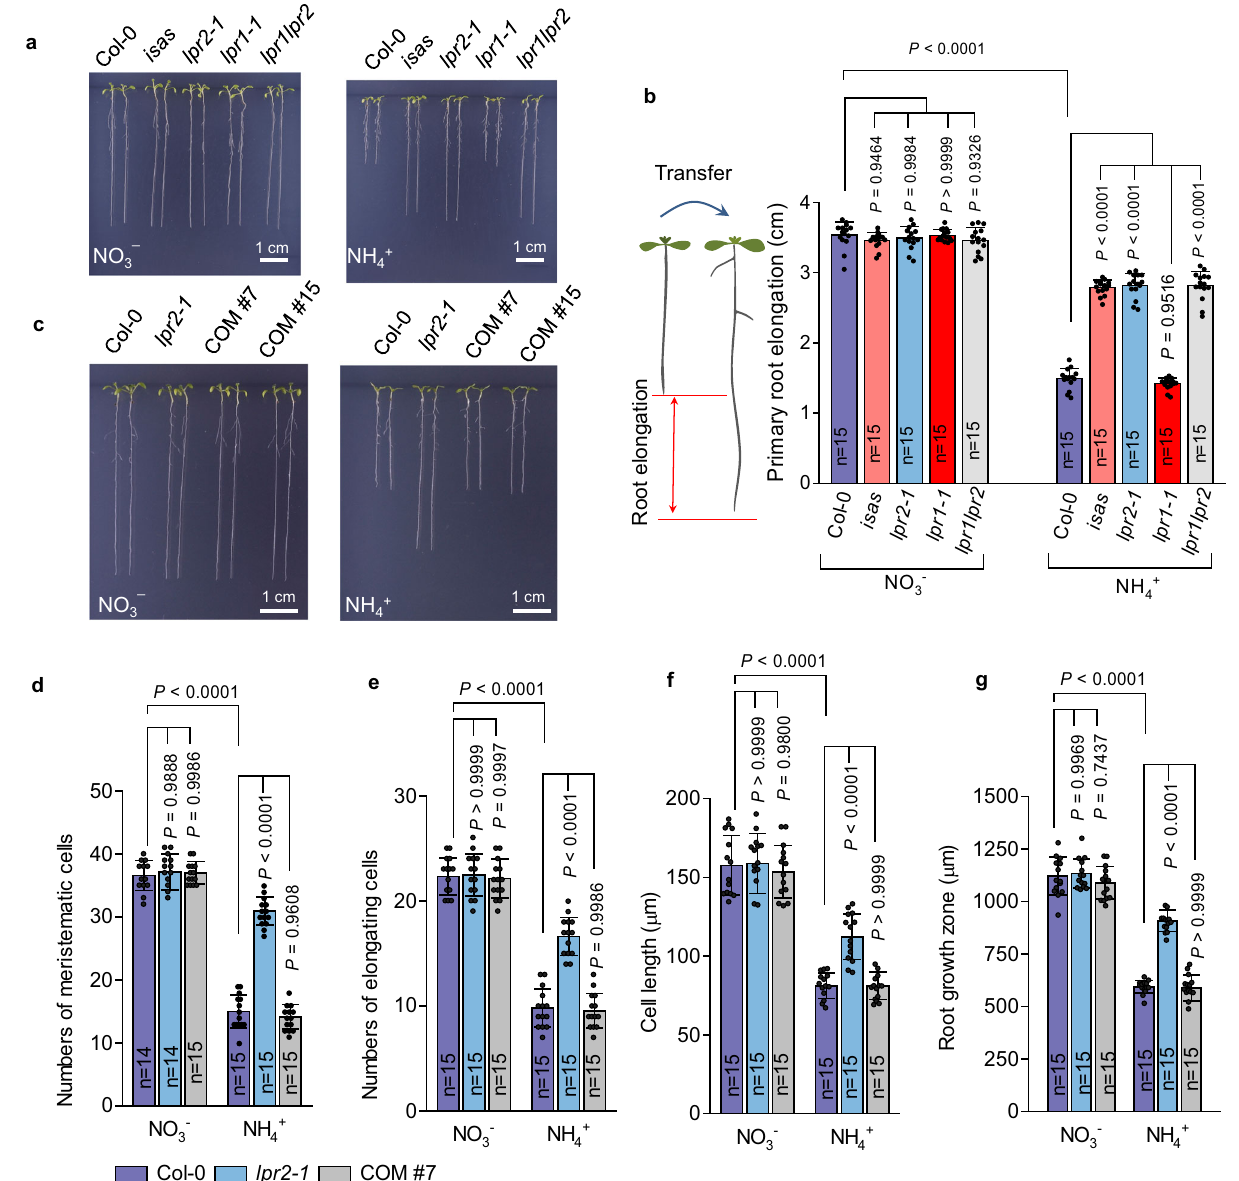
Fig. 1 LPR2-dependent growth inhibition of primary roots in NH4 + medium. a Phenotype comparison of Col-0 and the isas , lpr2-1 , lpr1-1 , and lpr1lpr2 mutants. b Elongation of primary roots. c Phenotype comparison of Col-0, lpr2-1 , and complementation lines (COM #7 and COM #15). d Number of meristematic cells. e Number of elongation cells. f Length of the fi rst differentiated cell. g Length of the root growth zone (elongation plus meristem zone). b , d - g Data shown are mean ± SD. P values < 0.05 indicate signi fi cant differences (two-way ANOVA with post-hoc Tukey HSD test; n = number of seedlings). Four-day-old seedlings of the indicated genotypes were transferred to NO 3 − or NH 4 + medium with 100 µ M Fe and analyzed 4 days after seedling transfer. Each experiment was repeated independently at least three times with similar results, and a representative experiment is